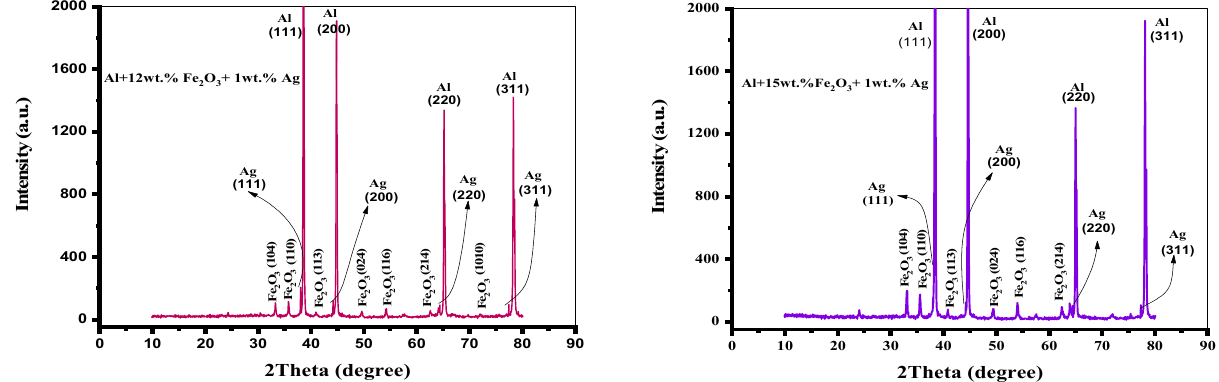
Figure 2. X-ray diffraction spectra of pure Al and Al/Fe 2 O 3 + Ag hybrid nano-composites. As shown in Figure 2, for the XRD data for the pure Al sample, the Al phase formed at 2 θ (38.485 ◦ , 44.735 ◦ , 65.135 ◦ and 78.285 ◦ ) for the planes at hkl (111, 200, 220 and 311), respectively. For the XRD data for the Al/3Fe 2 O 3 + 1Ag sample, in addition to the Al phase, the Ag phase formed at 2 θ (38.035 ◦ , 44.185, 64.385 ◦ and 77.435 ◦ ) for the planes at hkl (111, 200, 200 and 311), and the Fe 2 O 3 phase was created at 2 θ (33.185 ◦ , 35.585 ◦ , 49.485 ◦ , 54.085 ◦ and 62.485 ◦ ) for the planes at hkl (104, 110, 024, 116 and 214), respectively. For the XRD data for the Al/6Fe 2 O 3 + 1Ag sample, in addition to the Al and Ag phases, the Fe 2 O 3 phase formed at 2 θ (33.185 ◦ , 35.585 ◦ , 49.485 ◦ and 54.085 ◦ ) for the planes at hkl (104, 110, 024 and 116), respectively. For the Al/9Fe 2 O 3 + 1Ag sample, in addition to the Al and Ag phases, the Fe 2 O 3 phase formed at 2 θ (33.185 ◦ , 35.585 ◦ , 40.885 ◦ , 49.485 ◦ , 54.085 ◦ and 62.485 ◦ ) for the planes at hkl (104, 110, 113, 024, 116 and 214), respectively. In addition, the XRD data for the Al/12Fe 3 O 3 + 1Ag sample show that, in addition to Al and Ag phases, the Fe 2 O 3 phase was created at 2 θ (33.185 ◦ , 35.585 ◦ , 40.885 ◦ , 49.485 ◦ , 54.085 ◦ , 62.485 ◦ and 71.935 ◦ ) for the planes at hkl (104, 110, 113, 024, 116, 214 and hkl 1010), respectively. Finally, for Fe 2 O 3 phase was created at 2 θ (33.185 ◦ , 35.585 ◦ , 40.885 ◦ , 49.485 ◦ , 54.085 ◦ and 62.485 ◦ ) for the planes at hkl (104, 110, 113, 024, 116 and 214),